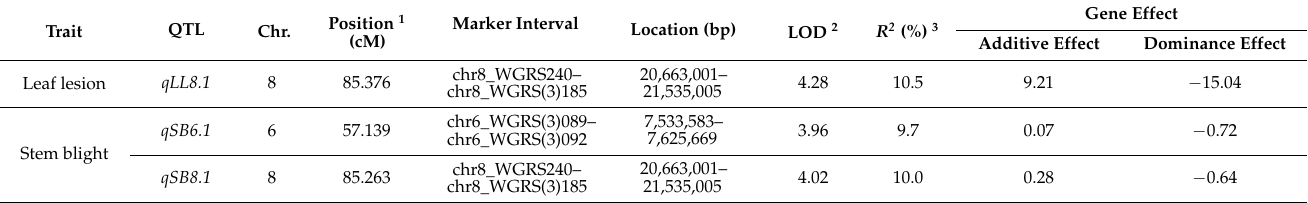
Figure 3. Quantitative trait loci (QTLs) associated with gummy stem blight (GSB) resistance on chromosome 6 and chromosome 8. ( a ) QTLs position of GSB resistance on chromosome 6 of the watermelon genetic map. QTL plot obtained by composite interval mapping (CIM) analysis on chromosome 6. LOD score at peak is 3.96. ( b ) QTLs position of GSB resistance on chromosome 8 of the watermelon genetic map. Major QTLs for stem blight (SB) and leaf lesion (LL) are represented by the blue and red, respectively. QTL plot obtained by composite interval mapping (CIM) analysis on chromosome 8. LOD score at peak for SB and LL is 4.02 and 4.28, respectively. Table 2. QTL mapping results for leaf lesion (LL) and stem blight (SB) traits on chromosome 6 and 8 in the F 2